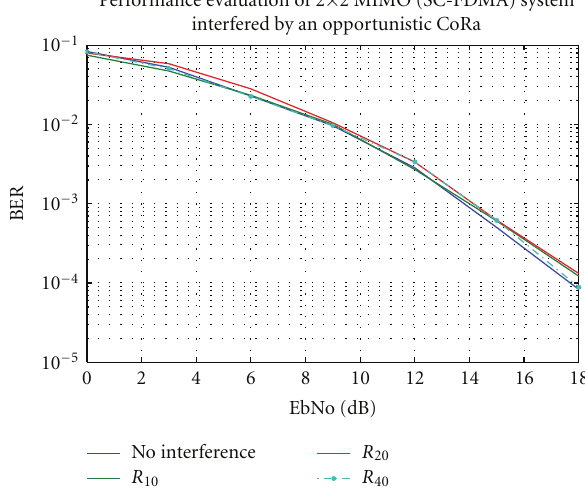
Figure 5: BER of the interfered primary user (MIMO SC-FDMA).